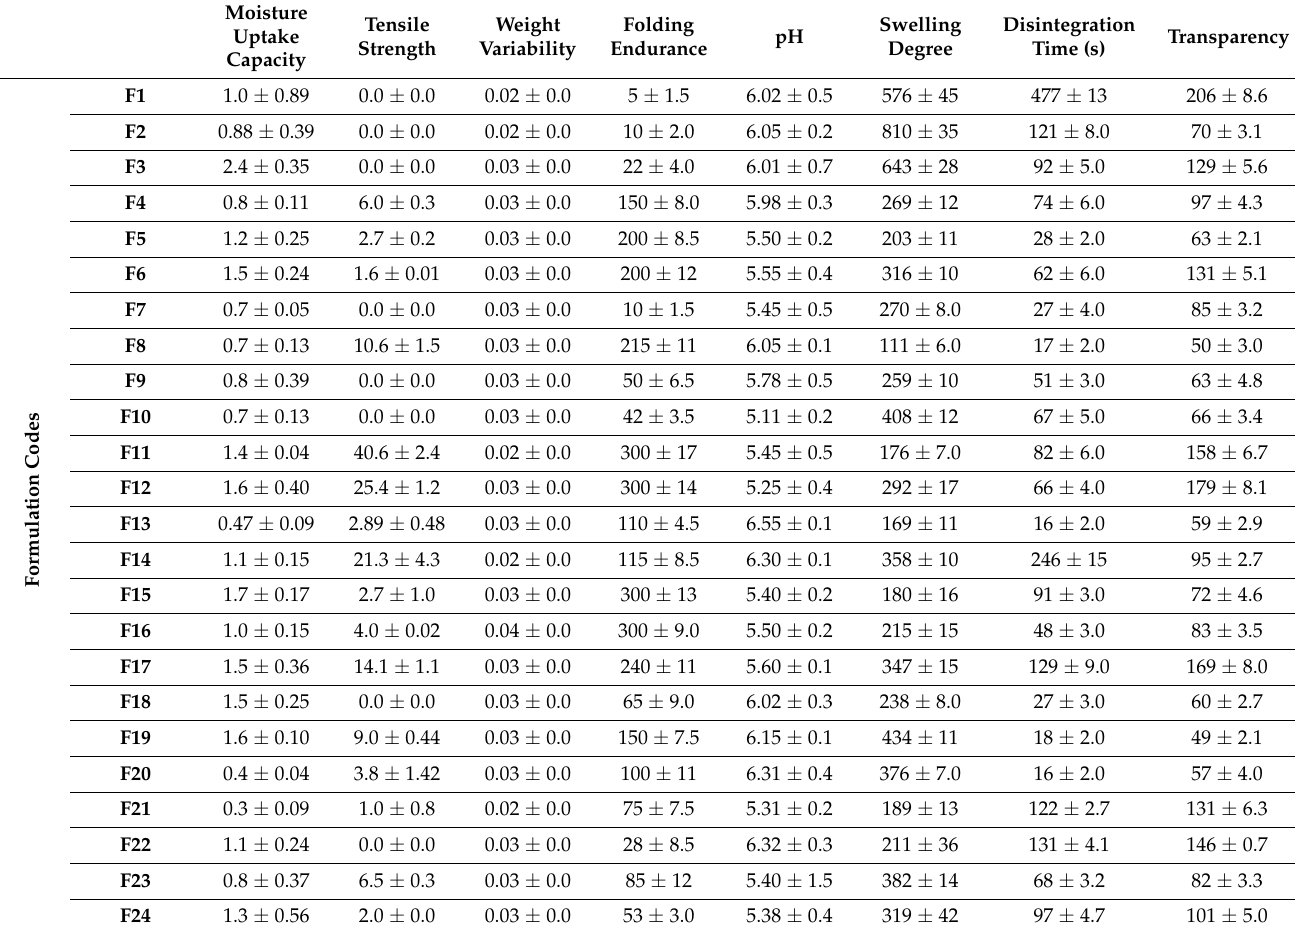
Figure 3. Blank OTFs ( left ), PG and MC included OTF ( right